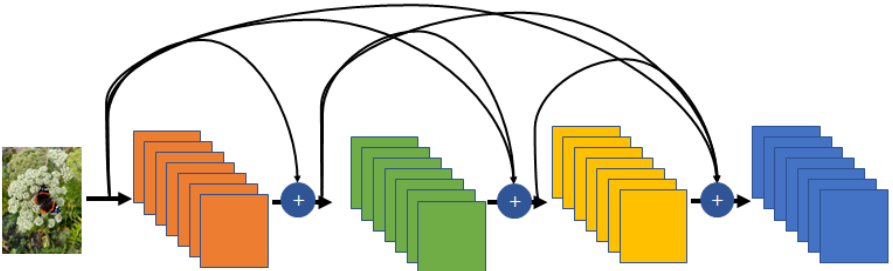
Figure 15. Basic structure of DenseNet. DenseNet involves channel-wise concatenation that connects to neurons not only on the next layer but also subsequent layers.